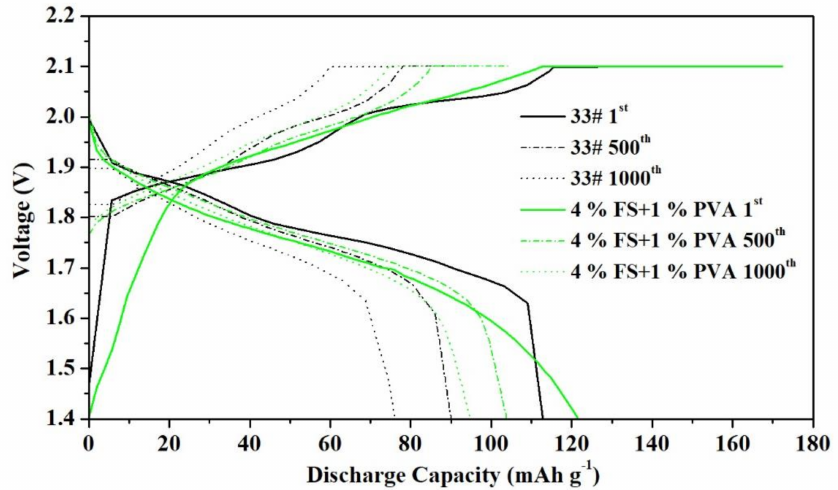
Figure 5. Voltage profile of the reference and the gel battery at 1st, 500th, and 1000th